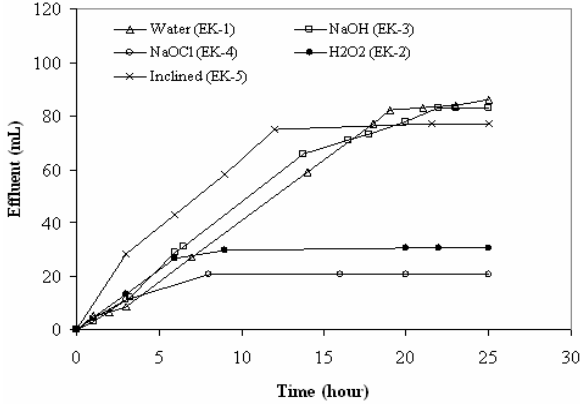
Figure 3 : Cumulative Volume of Effluent vs. Time